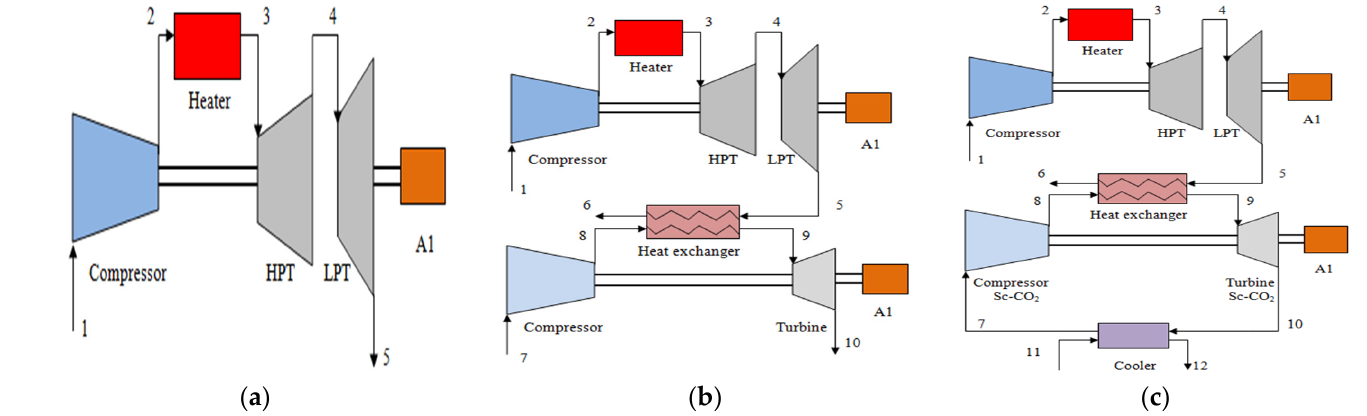
Figure 1. Layout of ASC ( a ), GT-ABC ( b ), and GT-sc-CO 2 BC ( c ) 1, 2, 3, 4, 5, 6, 7, 8, 9, 10, 11 and 12 are the inlet and outlet of each component of the cycles.